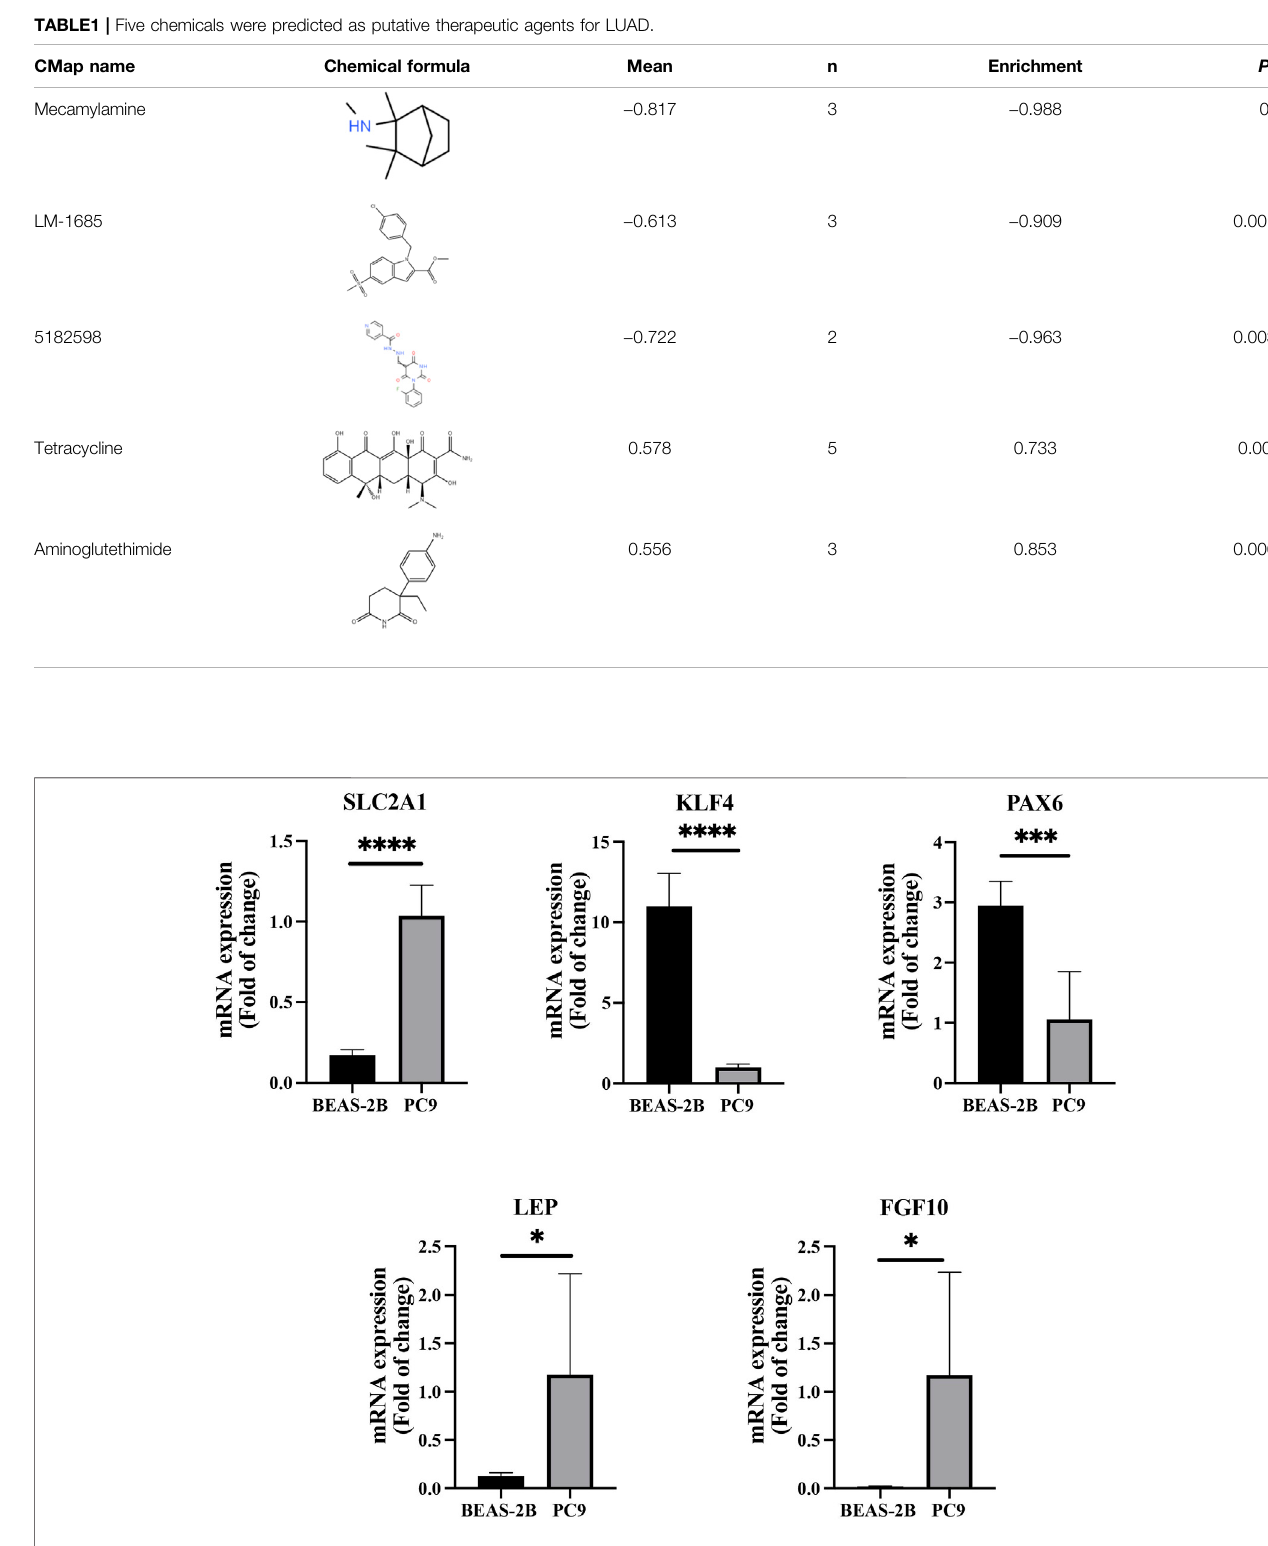
FIGURE 7 | Comparison of the expressions of the fi ve hub genes between the PC9 cell line and BEAS-2B cell lines.